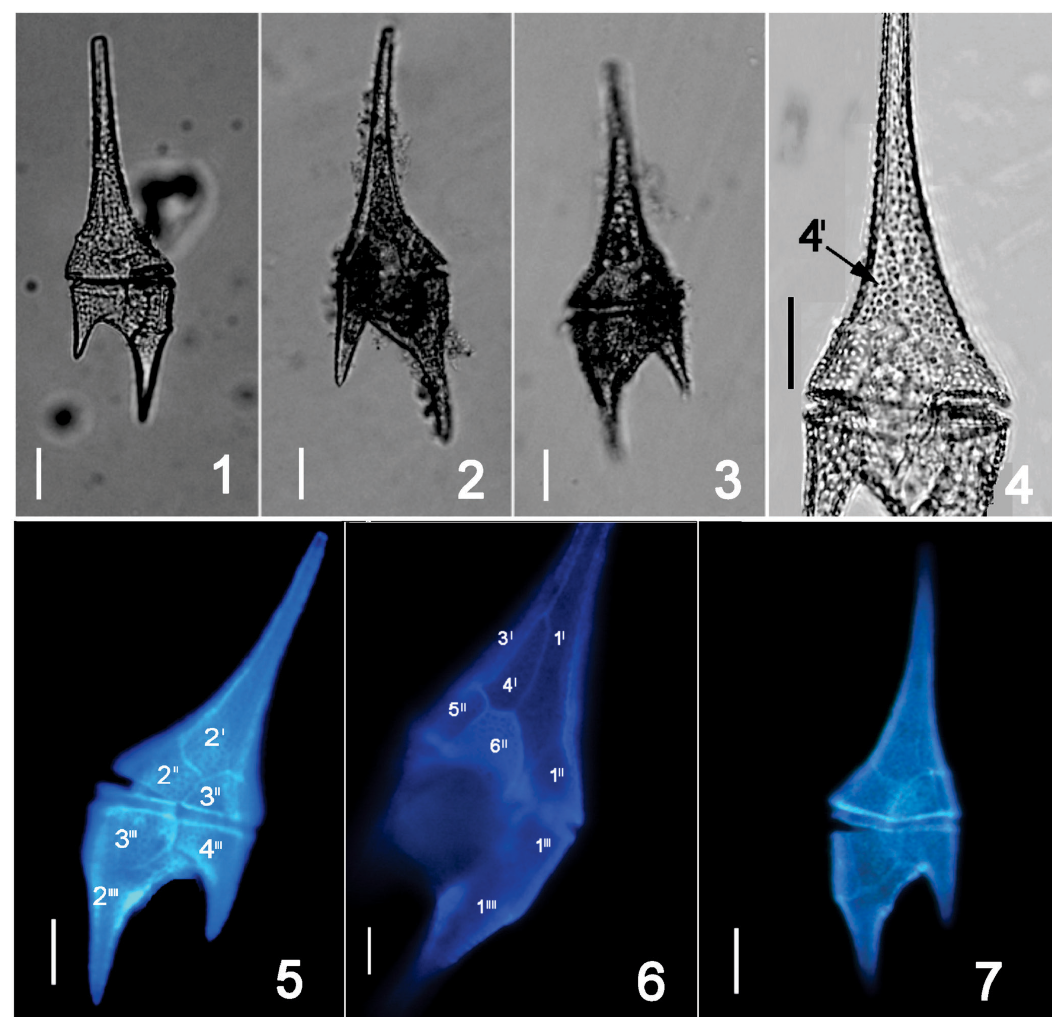
the apex. Figures 5-6: Populations from São Francisco River. Figure 5: Cell in dorsal view showing the apical (2’), precingular (2” and 3”), postcingular (3”’and 4”’) and antapical (2””) plates. Figure 6. Cell in ventral view showing the apical (1’, 3’ and 4’), precingular (1”, 5” and 6”), postcingular (1”’) and antapical (1””) plates; note the fourth apical plate (4’) not reaching the apex. Scale bars: 20